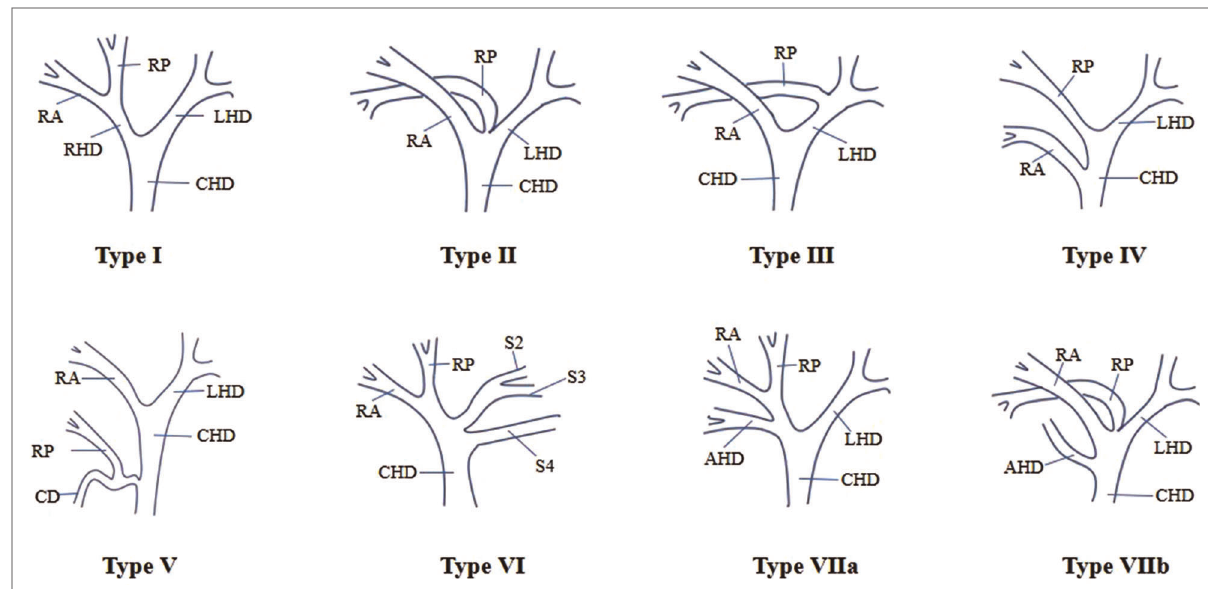
FIGURE 1 Intrahepatic bile duct anatomy based on three-dimensional biliary tract reconstruction. Type I shows a typical anatomical structure of the biliary tract. Type II is triple con fl uence, i.e., RASD, RPSD, and LHD con fl uence into the CHD. Type III shows abnormal RPSD drainage to LHD, abnormal RPSD drainage to the CHD, and abnormal RPSD drainage to the CD. In type VI, there is no true LHD, and the bile duct draining segment 4 and the bile duct draining segments 2 and 3 are inserted into the CHD, respectively. Type VII has AHD, and it can be divided into type VIIa and type VIIb, according to the opening position of AHD. In type VIIb, there are also type II variants besides the opening of AHD in the CHD. RPSD=right posterior segmental duct, RASD=right anterior segmental duct, RHD=right hepatic duct, LHD=left hepatic